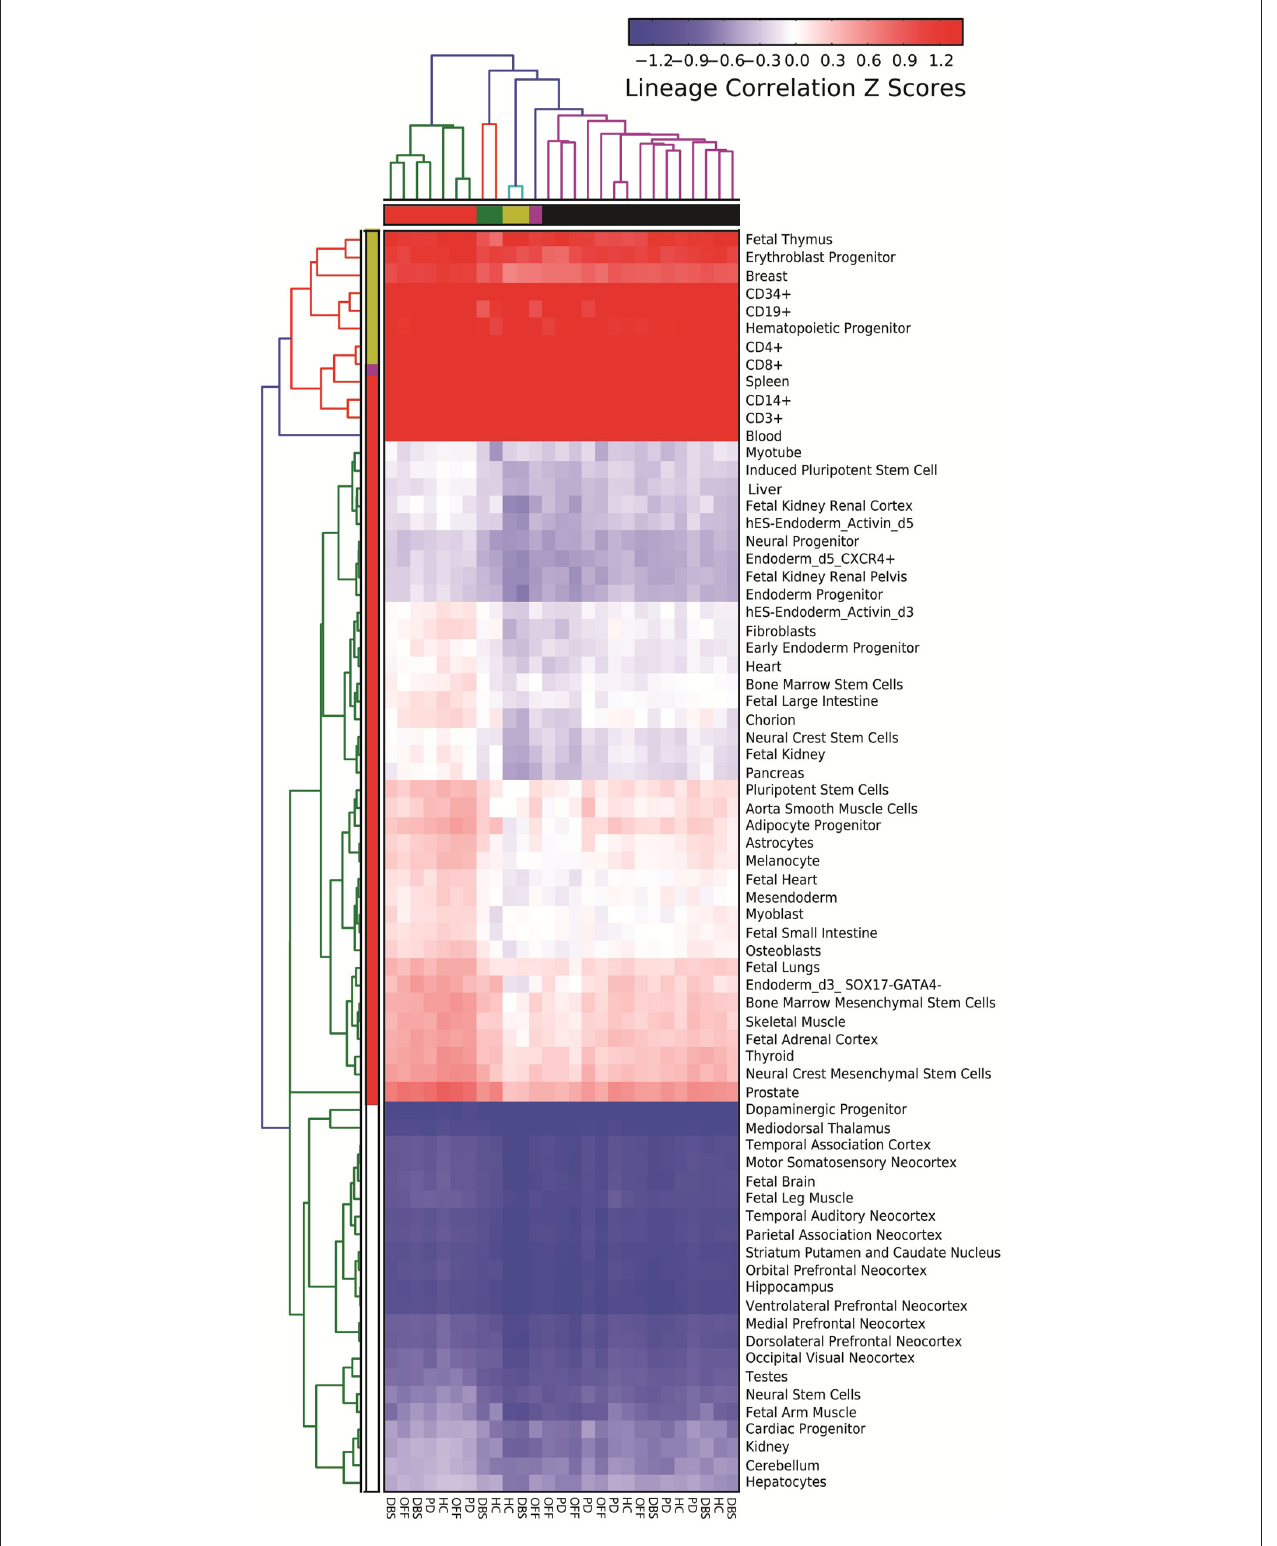
FIGURE 5 | Tissue and cell type origins of leukocyte-expressed AS-modified long transcripts. Putative cell and tissue specific markers subjected to alternative splicing in the leukocyte RNA samples from tested